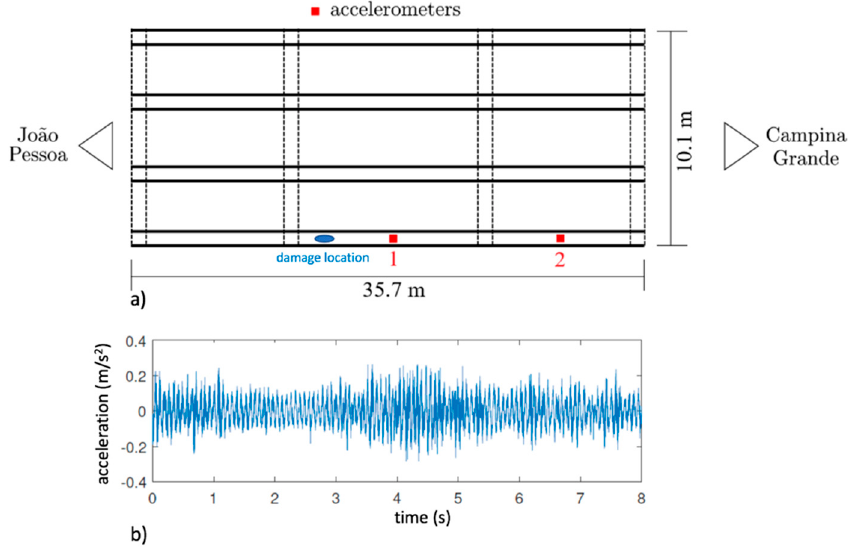
Figure 10. Várzea Nova viaduct. ( a ) Top view and experimental setup. ( b ) Typical response for accelerometer 1. Table 4. Variation of the first natural frequency of the Várzea Nova viaduct.